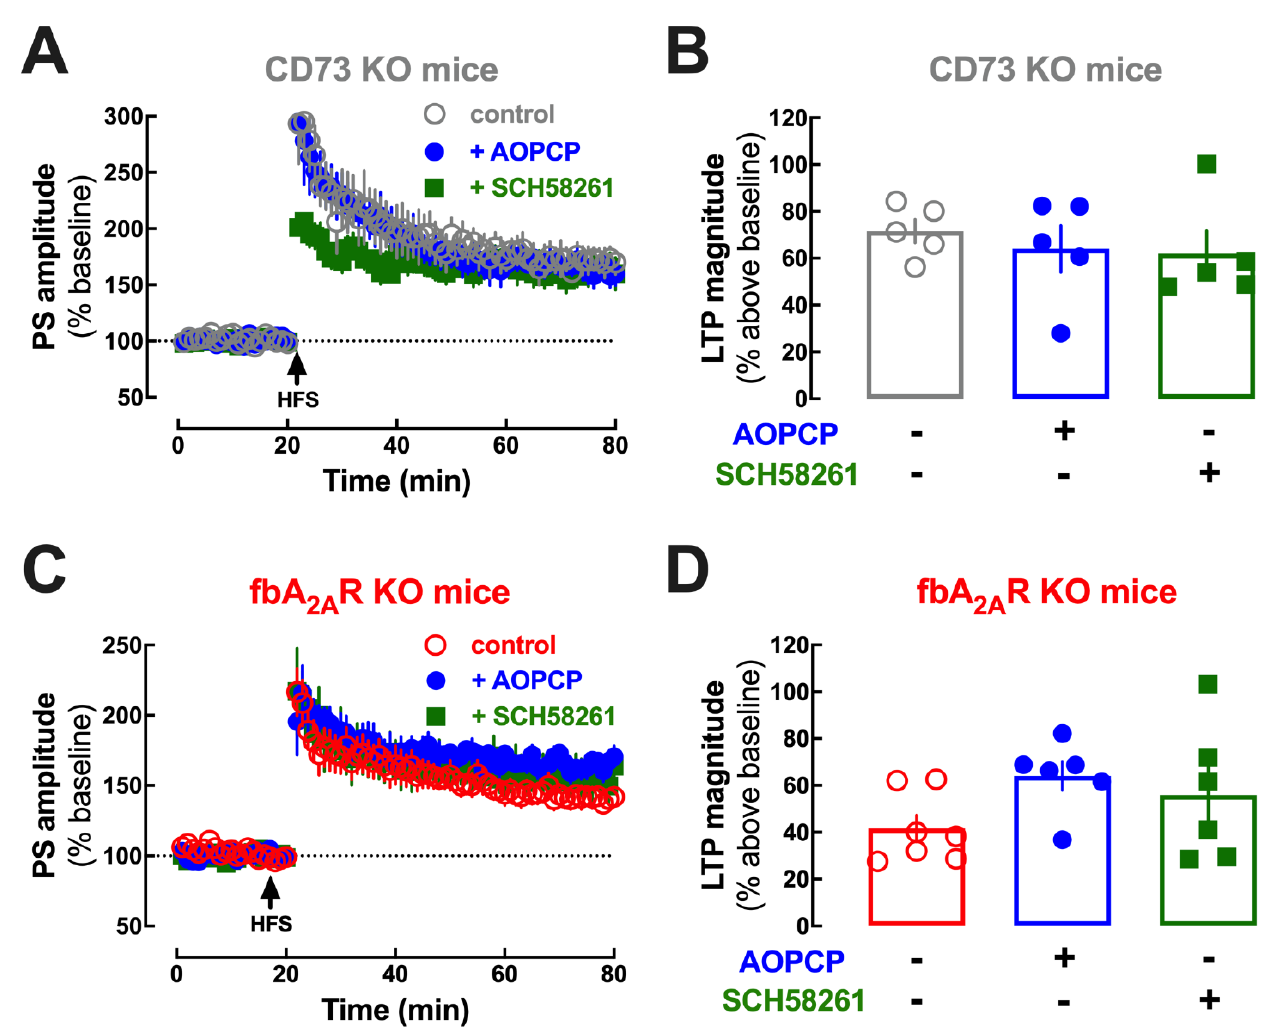
Figure 7. CD73 derived adenosine activates A 2A R controlling LTP in amygdala slices. The effect of both the CD73 inhibitor, AOPCP (100 µ M) and of the A 2A R antagonist, SCH58261 (50 nM), on the magnitude of long-term potentiation (LTP) induced by high-frequency stimulation (HFS: 3 × 100 Hz at 5 s intervals) at excitatory synapses between projections of the external capsule (EC) and the lateral amygdala (LA) was eliminated in both CD73 KO mice and in forebrain neuronal (fb)A 2A R KO mice. ( A ) Time course and ( B ) average LTP magnitude in slices from CD73 KO mice, showing that both AOPCP and SCH58261 did not change LTP magnitude. ( C ) Time course and ( D ) bar graph of LTP magnitude in slices from fbA 2A R KO mice, showing that both AOPCP and SCH58261 did not change LTP magnitude. The values are mean ± SEM of n = 5–7 experiments.